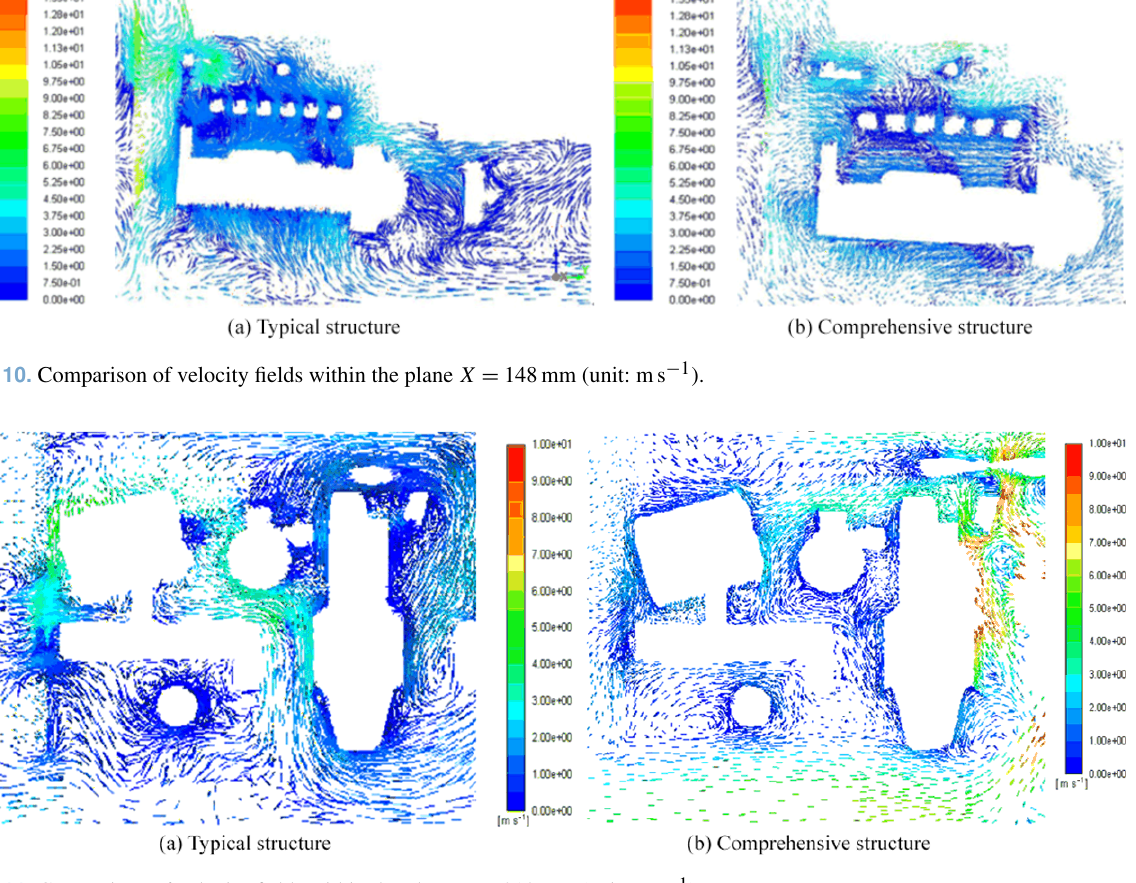
Figure 11. Comparison of velocity fields within the plane Y = 810mm (unit: ms − 1